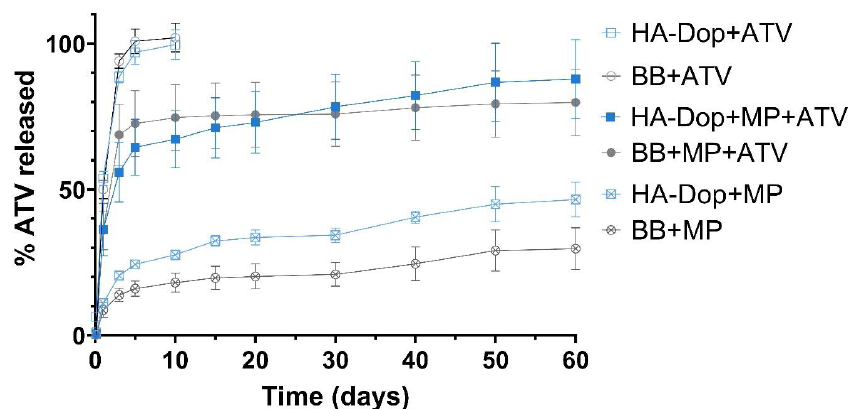
Figure 5. Release curves of the formulations obtained with the Transwell ® set-up. Free ATV is diffused within the first 10 days from both the HA-Dop and the control. In the formulations with both free ATV and MPs, there is a high burst effect, mainly provided by the free drug. In the formulations with MPs only, the release is sustained throughout the study. N = 3, error bars = SD.